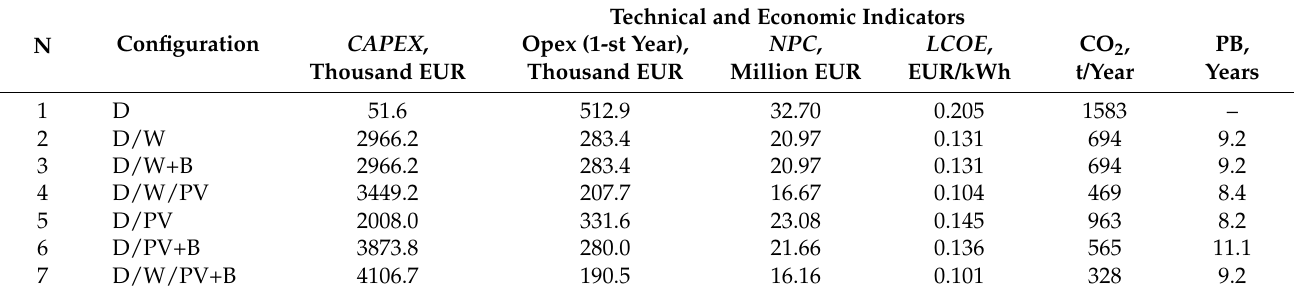
Table 8. Technical and economic indicators of the considered HES